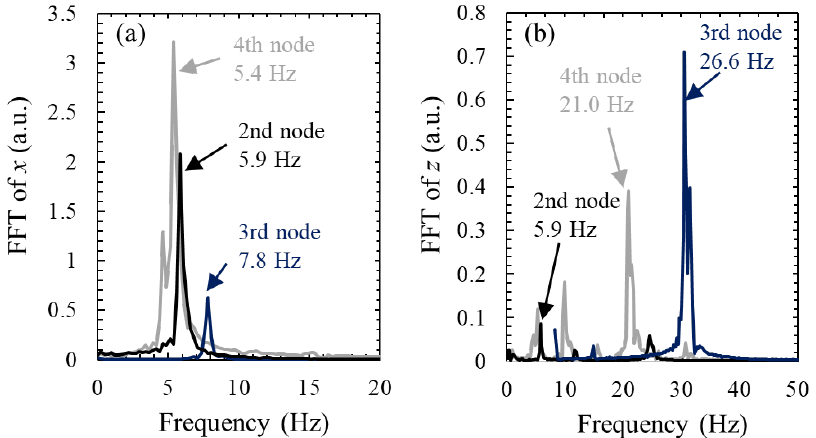
Figure 5. FFT analysis for the ( a ) horizontal and ( b ) vertical oscillations of three levitated droplets. The arrow represents the primary frequency of the corresponding case.